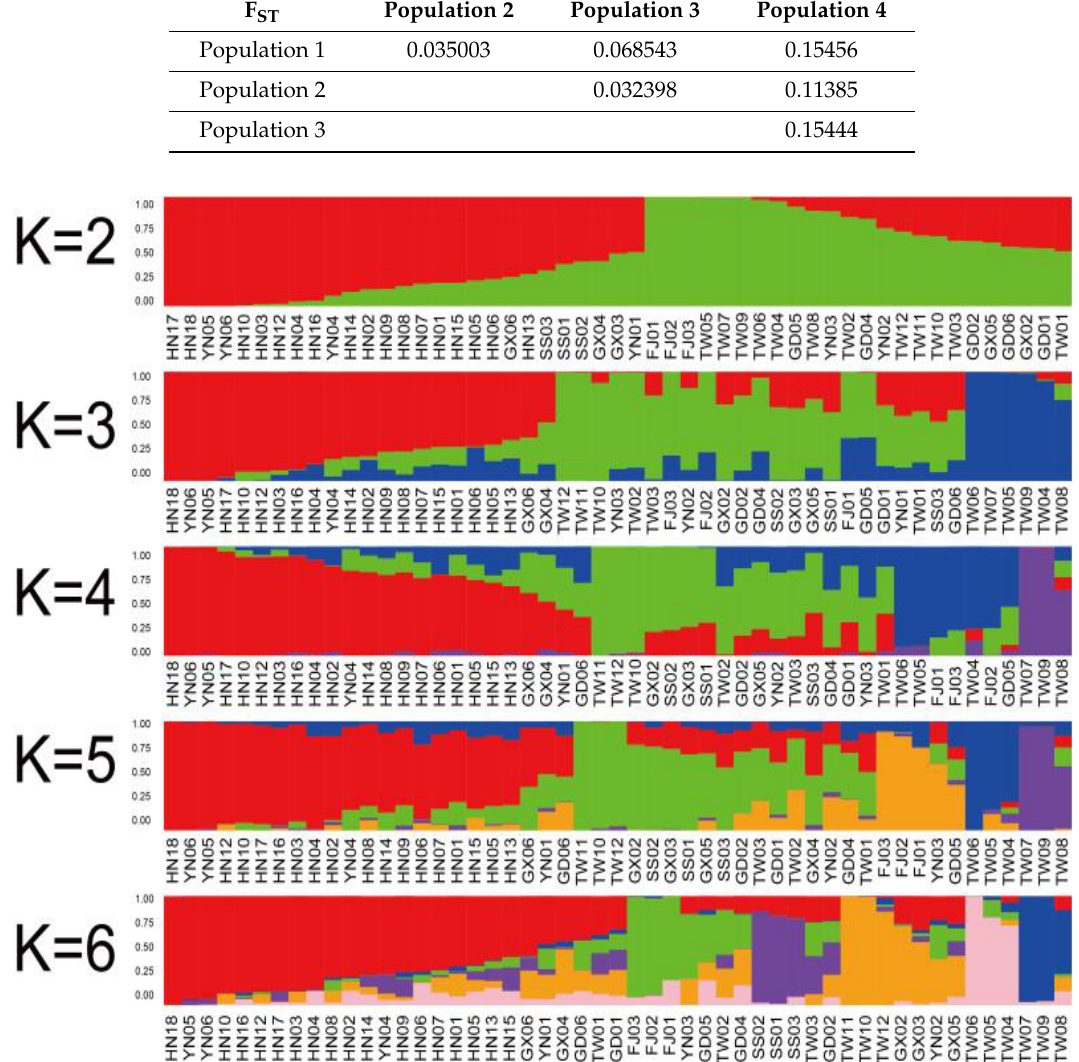
Figure 2. Bayesian plot (K) of group assignment of each accession into 2 to 6 cluster structure analysis of B. longissima . The results are grouped by location of sample collections. Each vertical column represents one accession and the coloration is proportional to the accessions estimated membership coefficient in one of the clusters.